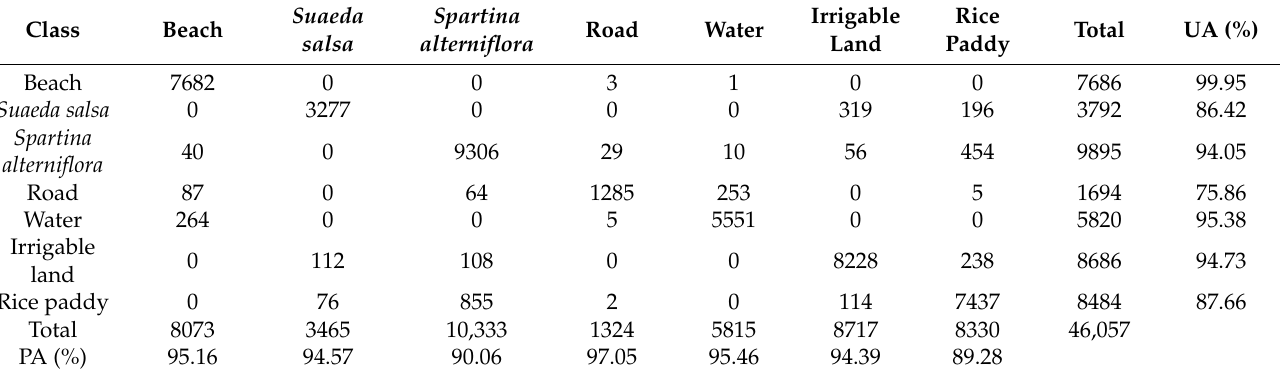
Table 4. Confusion matrix of the classification results from the FS features set using random forest.